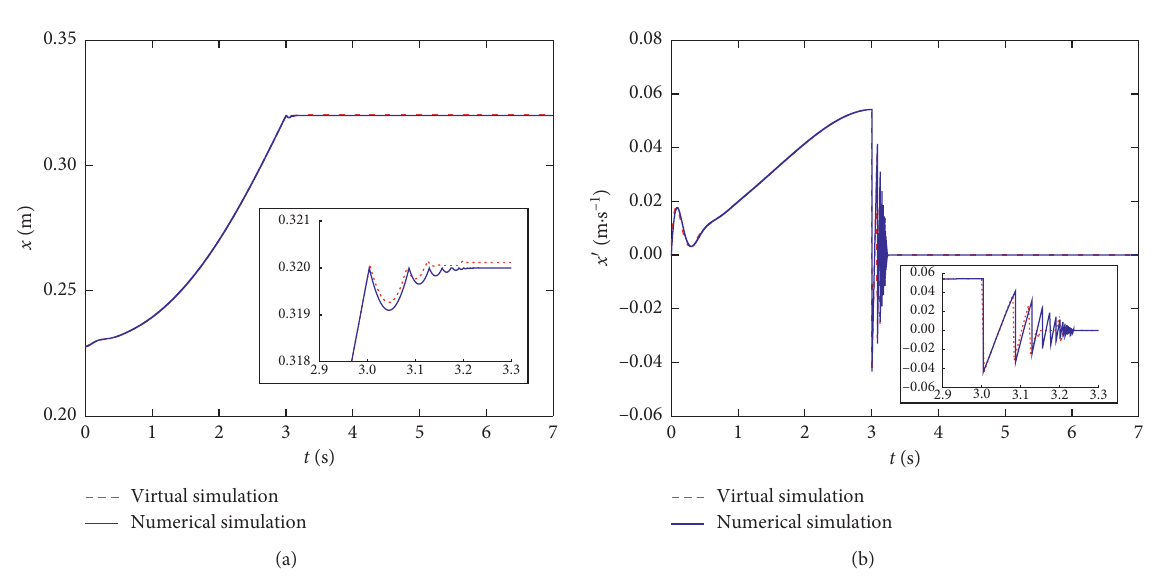
Figure 17: (a) Position variation of the slider. (b) Velocity variation of the slider.